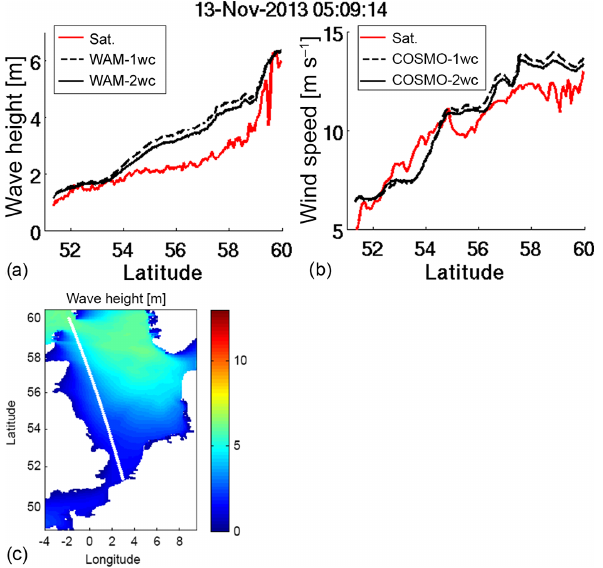
Figure 6. Time series of wave height (m) and wind speed (ms − 1 ) from the Saral/AltiKa data and as modelled by WAM-NS under calm weather conditions on 13 November 2013. The track of the satellite (the white line) is shown together with the model signifi- cant wave height at the time of the passage (bottom panel).